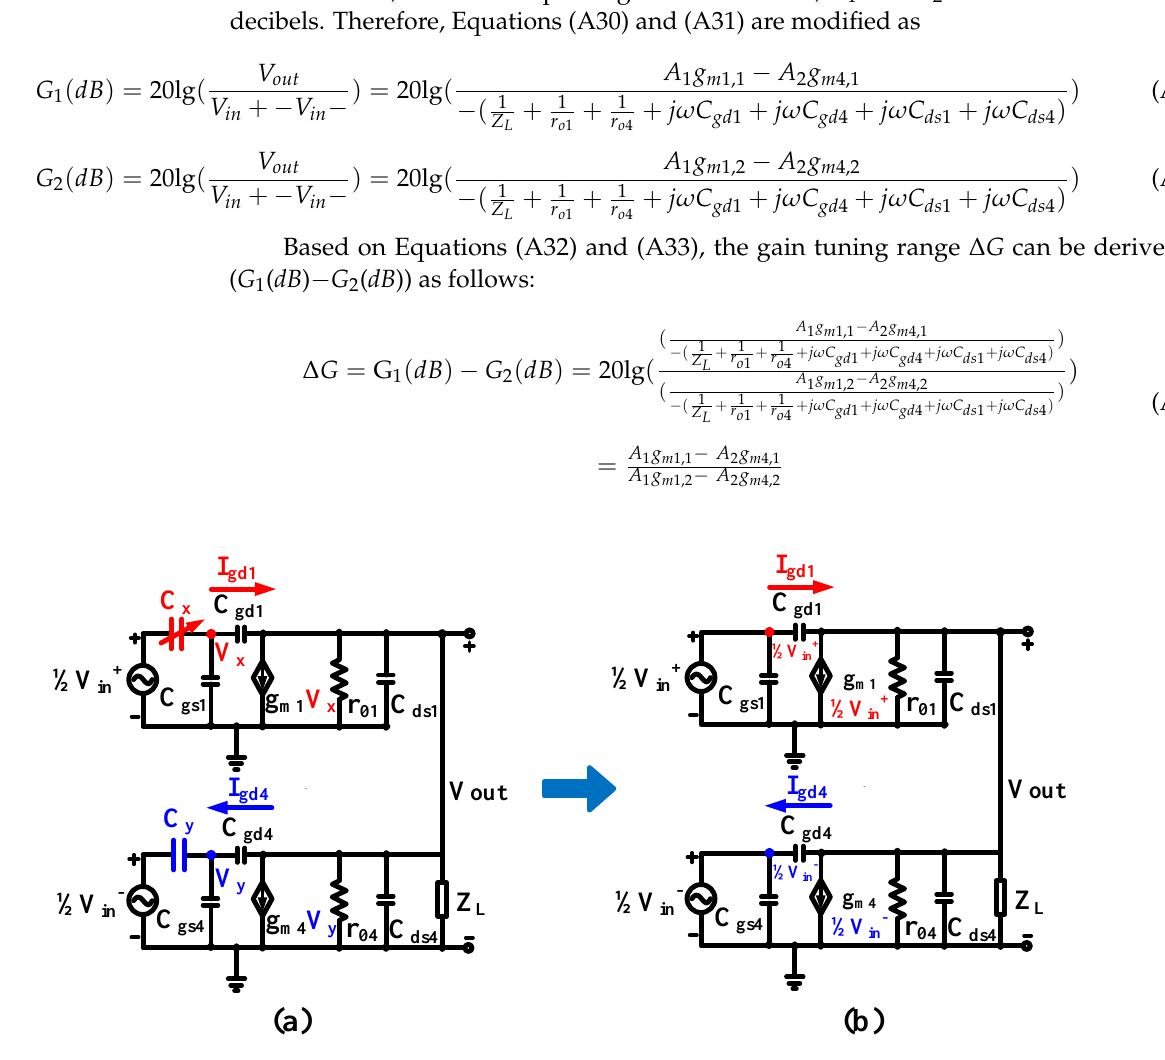
Figure A3. ( a ) Half-side small-signal equivalent circuit of the proposed variable gain stage with asymmetric capacitors; ( b ) half-side small-signal equivalent circuit of the proposed variable gain stage without asymmetric capacitors.